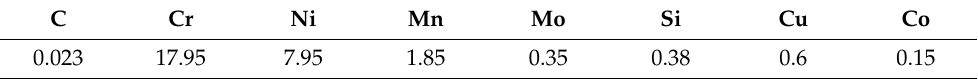
Table 1. Chemical composition analysis results for the austenitic steel under study, wt%. C Cr Ni Mn Mo Si Cu